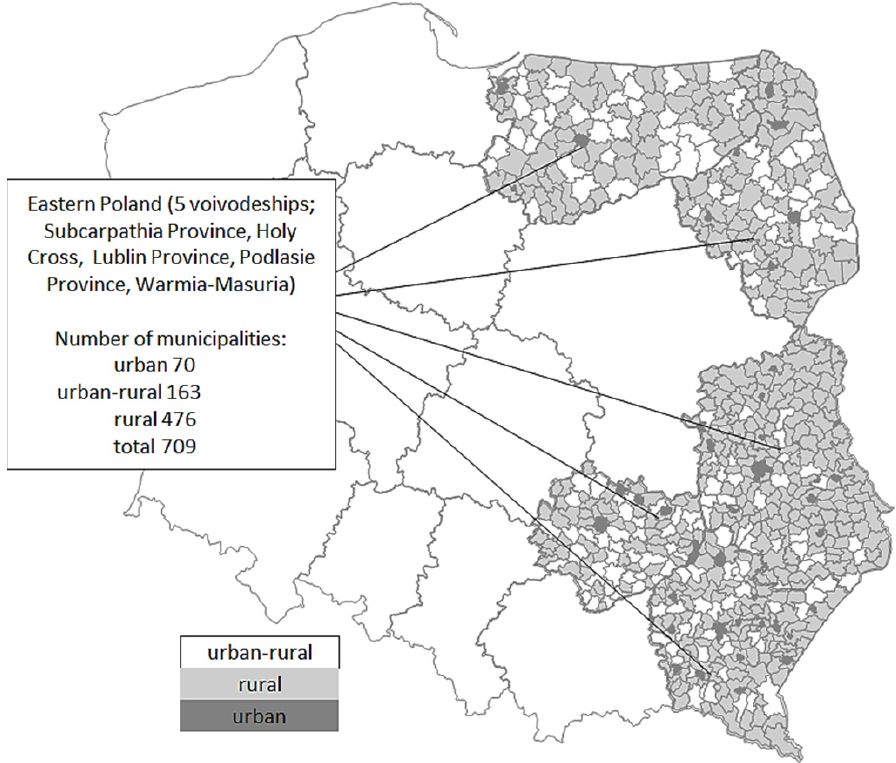
Figure 3. Study area—communes of Eastern Poland Sources: own study.